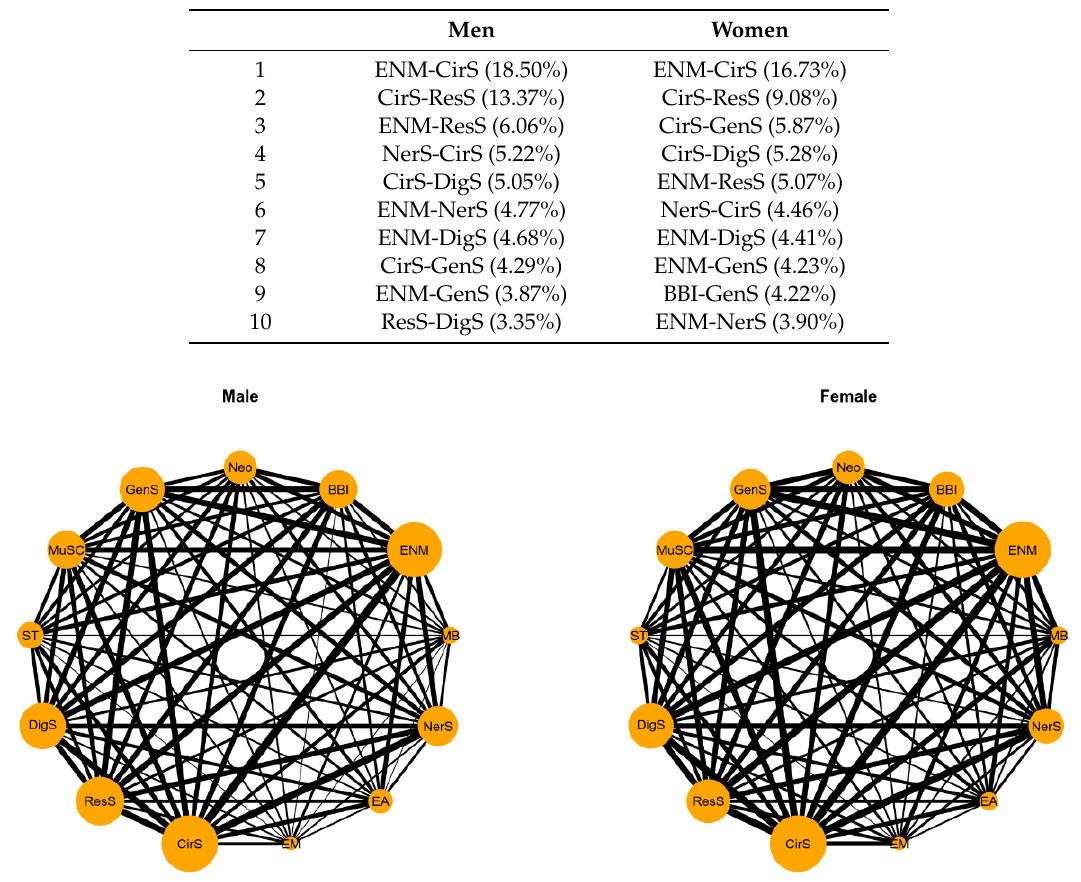
Figure 3. Multimorbidity networks by gender for 13 systemic diseases.